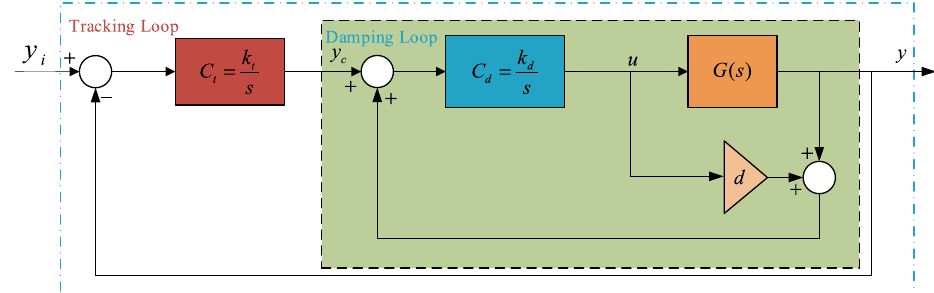
Figure 3. IRC control block diagram.